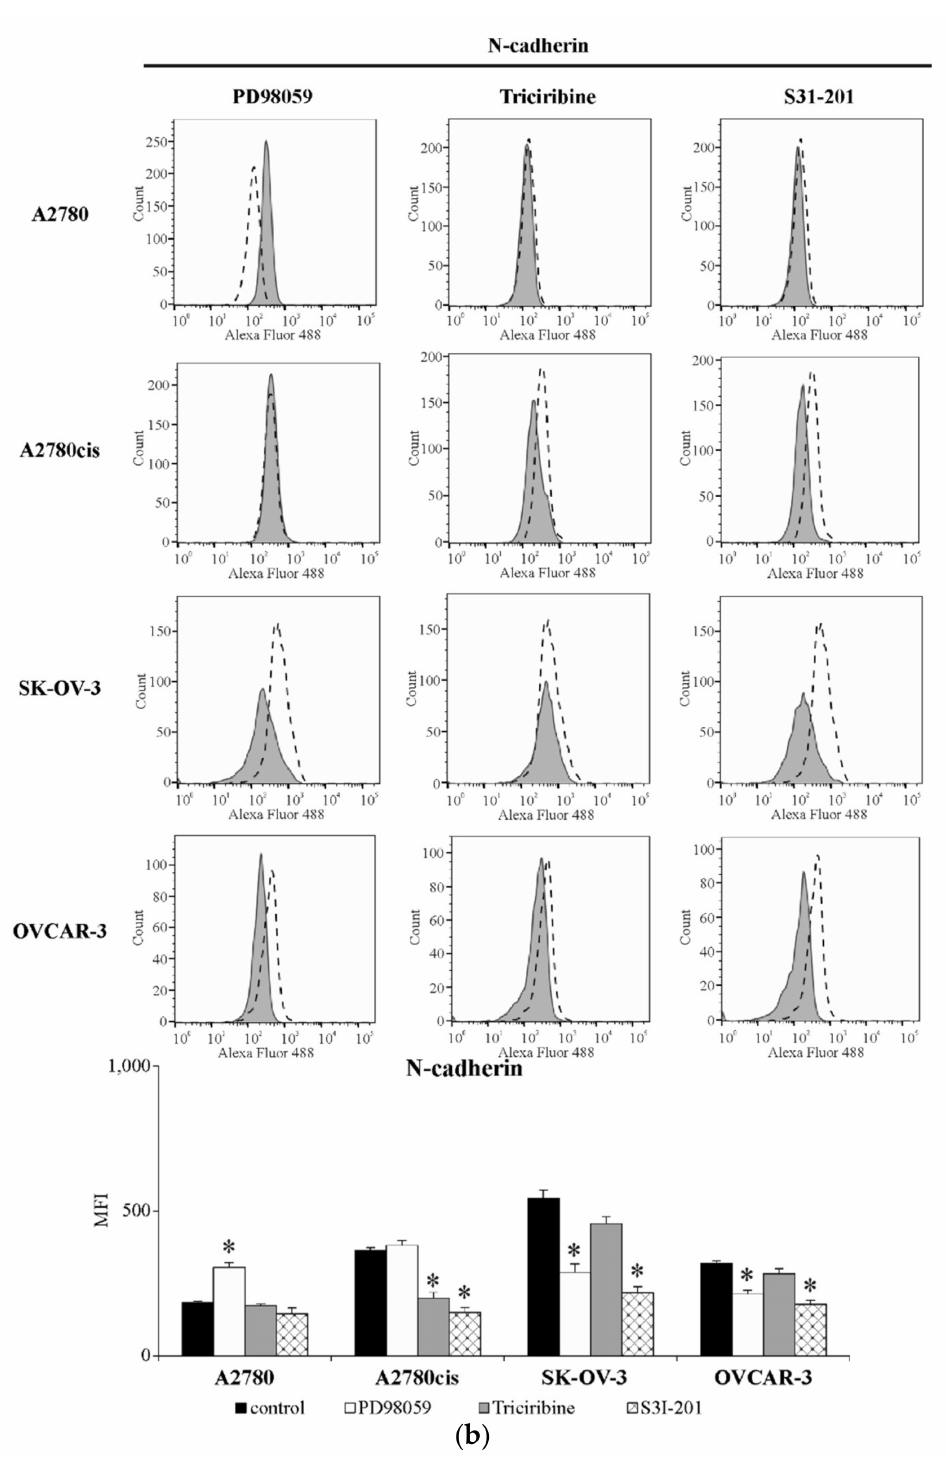
Figure 8. The level of E-cadherin and N-cadherin in A2780, A2780cis, SK-OV-3 and OVCAR-3 cells treated with inhibitors. All cell lines were cultured with PD98059 (50 µ M) or Triciribine (50 or 100 µ M) or S3I-201 (50 or 100 µ M) or not (control) for 48 h. Surface expression of both cadherins was determined by staining cells with antibodies, targeting either E-cadherin (Abs conjugated with PE fluorochrome) or N-cadherin (Abs conjugated with Alexa Fluor 488 fluorochrome) and measuring the intensity of fluorescence with the use of flow cytometry. Representative histograms of E-cadherin ( a ) or N-cadherin ( b ) expression in cells treated with PD98059 or Triciribine or S3I-201 (grey graph) in regard to the E-cadherin or N-cadherin expression in untreated cells (dashed line graph) are shown. The acquired data are presented as the mean of median fluorescence intensity (MFI) ± SD from five independent experiments ( n = 5). * Statistically significant change in E-cadherin or N-cadherin level: PD98059 or Triciribine or S3I-201 vs. control, p ≤ 0.03 (Wilcoxon’s singed rank